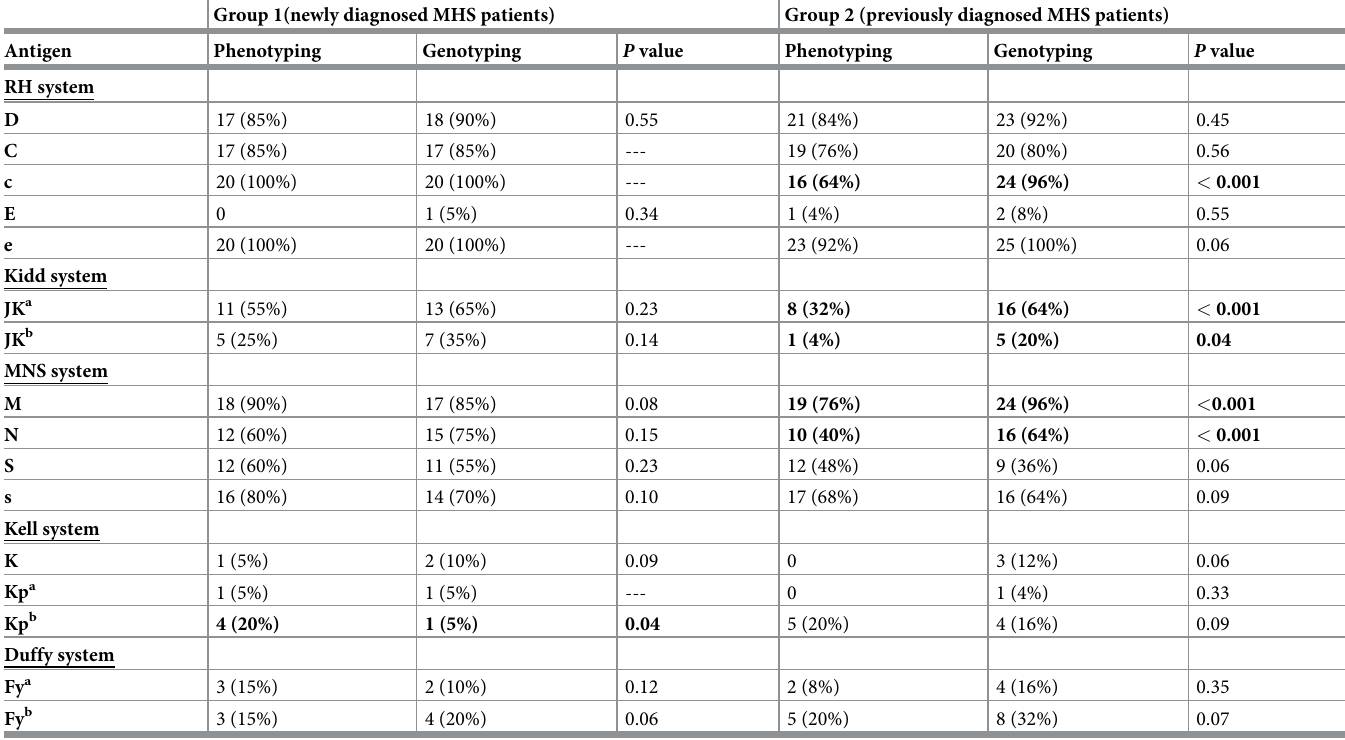
Table 2. Comparison between the results of genotyping and phenotyping of the 16 non-ABO erythrocyte antigens in the study patients’ groups. Group 1(newly diagnosed MHS